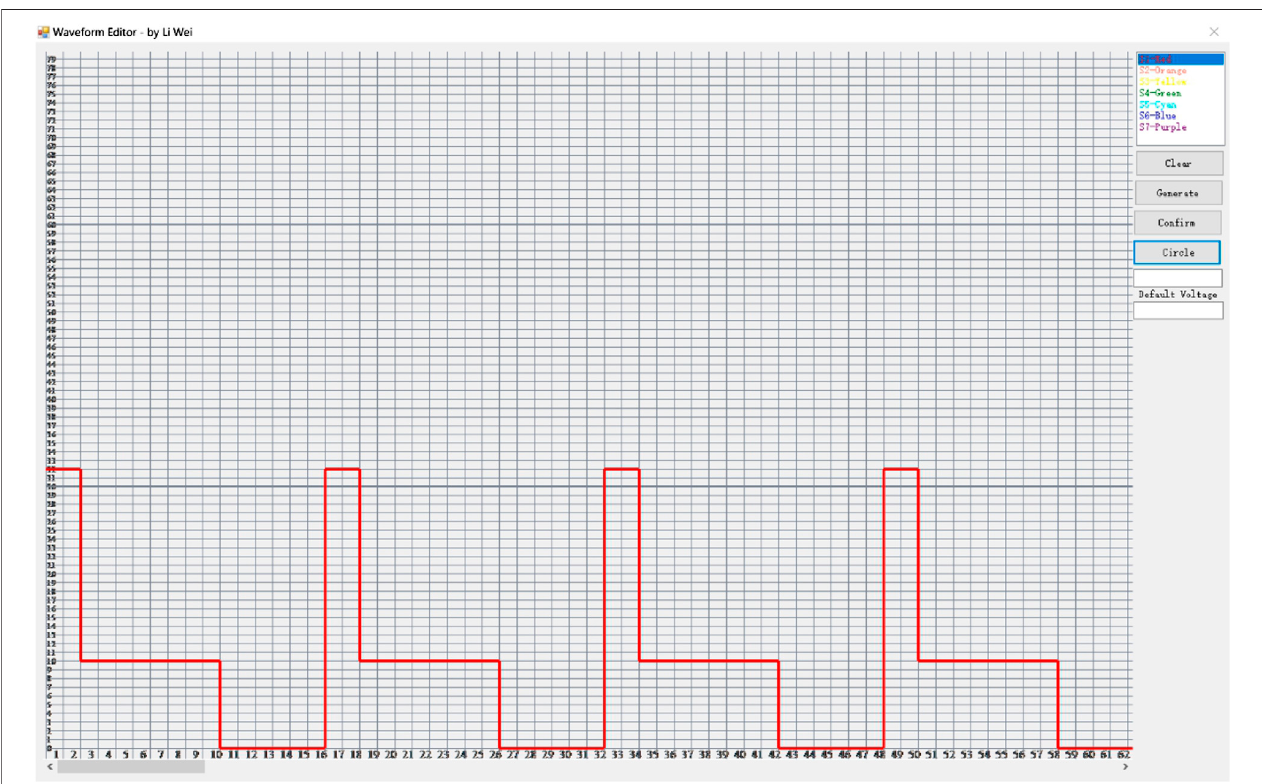
FIGURE6| Thescreenshotofthewaveformeditor.Thewaveformeditorcouldimplementthedesignofanarbitrarywaveformandgeneratewaveformdataquickly.